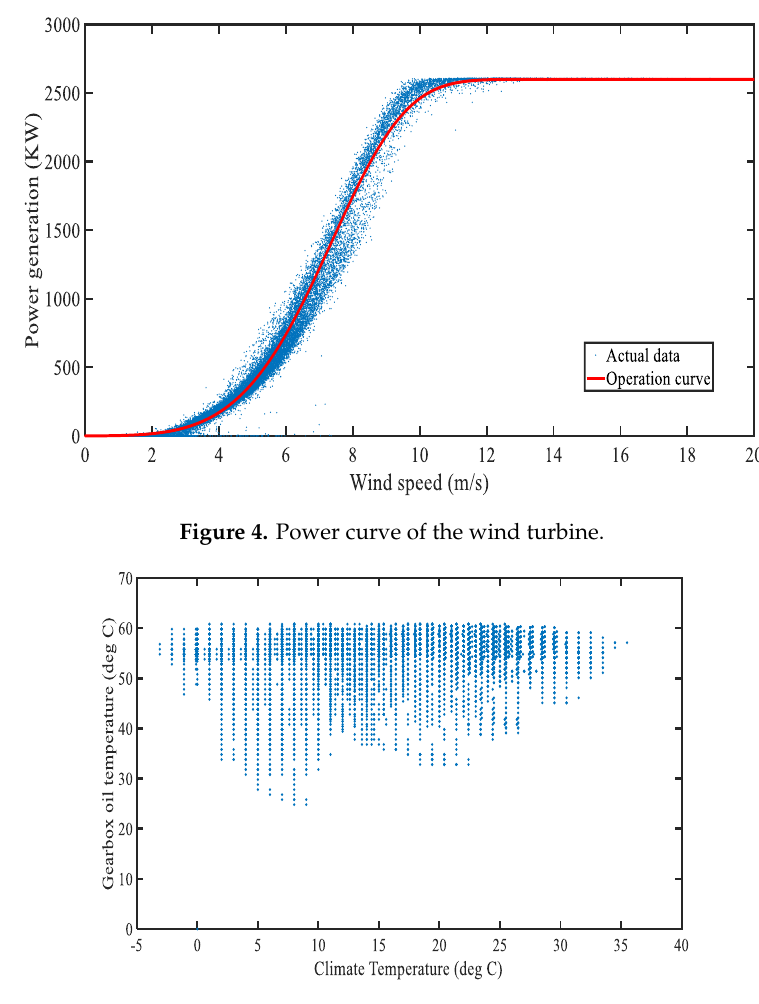
Figure 5. Relationship between the gearbox oil temperature and air temperature.